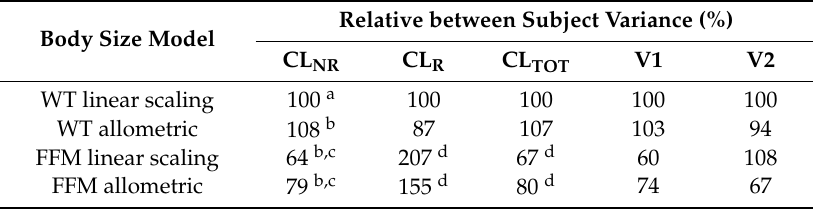
Table 5. Comparison of between-subject variability estimates between di ff erent body size